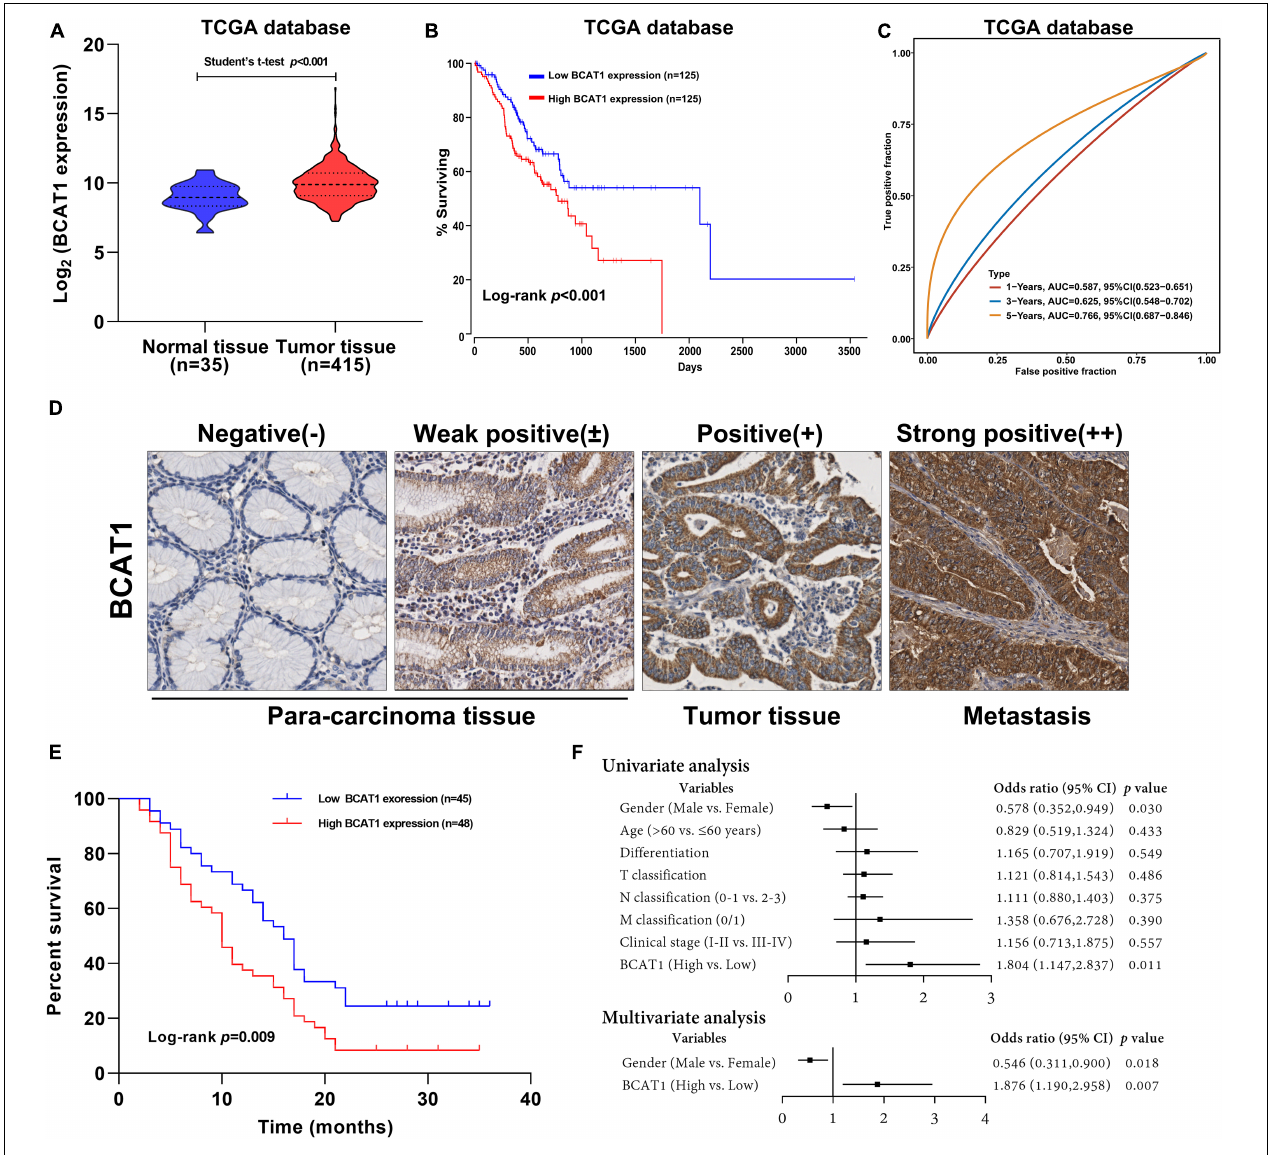
FIGURE 1 | BCAT1 is a negative prognostic factor for patients with GC. (A) Expression of BCAT1 in tumor tissues and normal tissues from TCGA GC dataset. (B) Kaplan–Meier survival curve for OS in TCGA GC dataset, classified by BCAT1 expression (high: FPKM values above the 66th percentile; low: FPKM values below the 33rd percentile). (C) Time-dependent ROC analysis of BCAT1 in TCGA GC dataset. (D) Representative IHC images for the clinical samples from 95 GC patients (E) Kaplan–Meier survival curve of OS according to BCAT1 IHC staining in 95 GC patients (high: positive expression; low: negative expression). (F) Forest plot of the Cox regression analysis in 95 GC